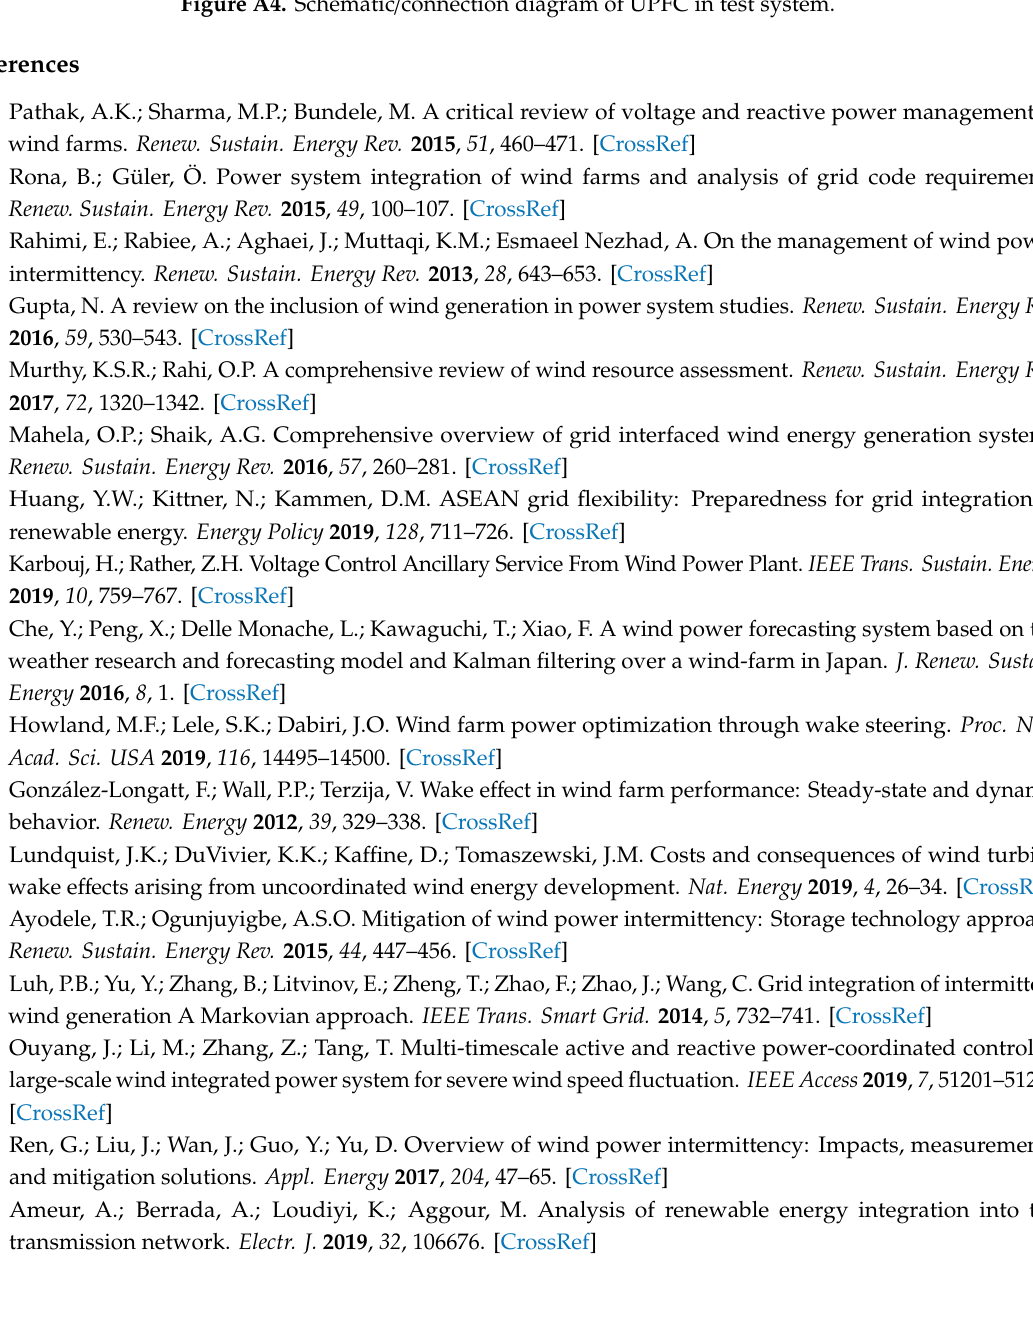
Figure A4. Schematic / connection diagram of UPFC in test system.